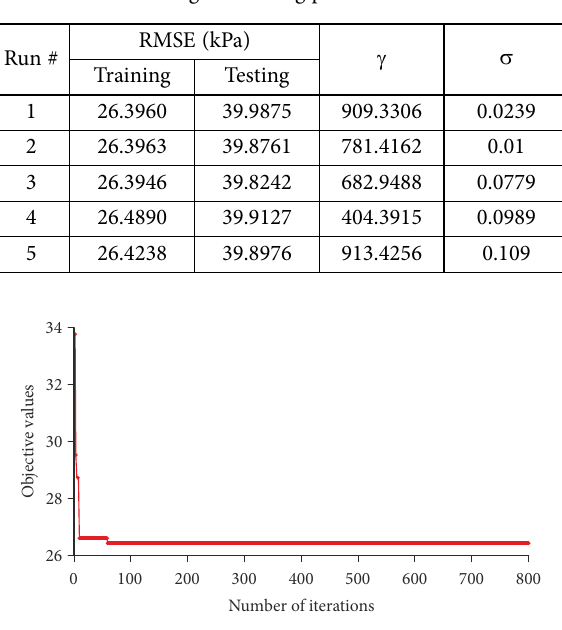
Figure 3. Convergence procedure of IPSO